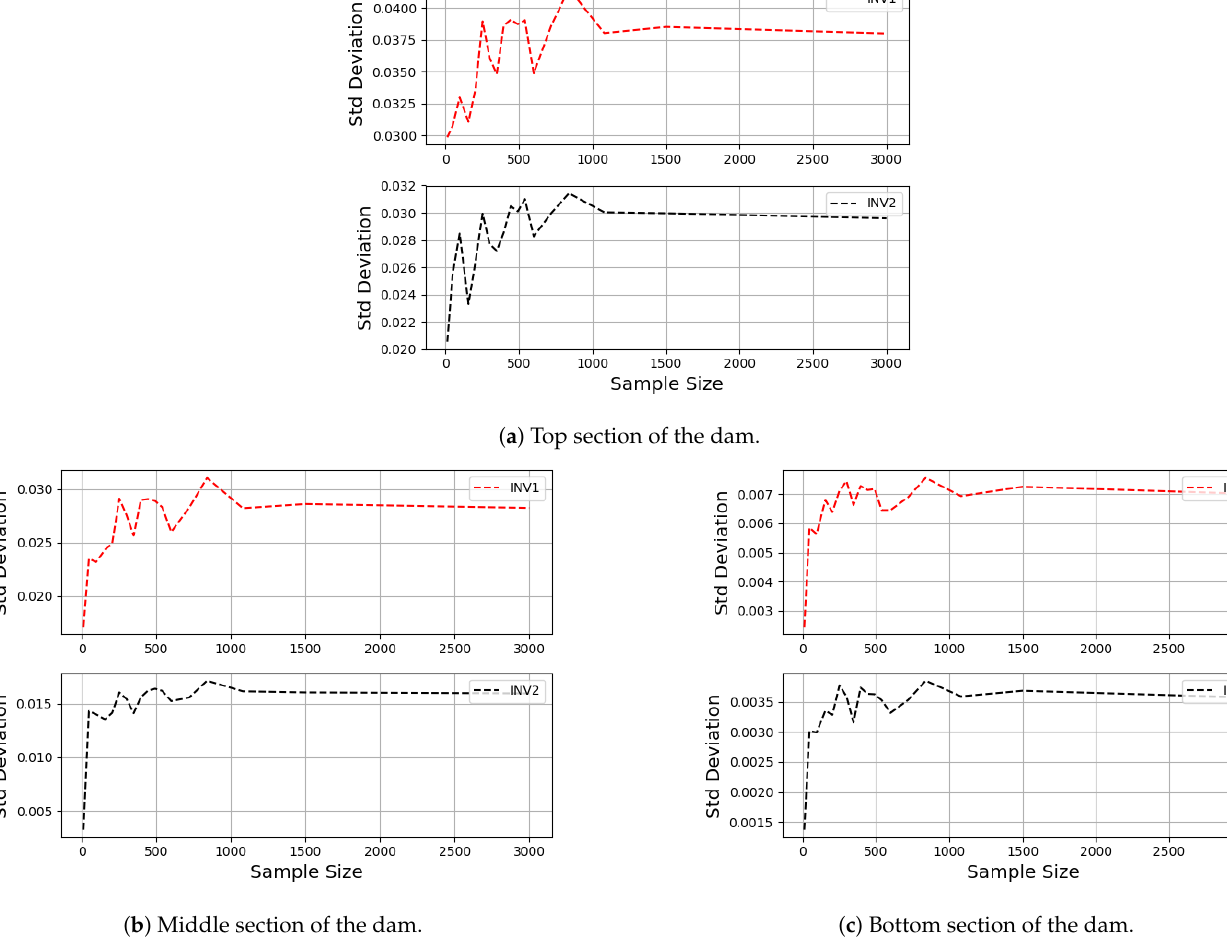
Figure 4. Variations of standard deviation (of the vertical displacement) with respect to the sample size for each inclinometer. The plots are built for the nodes close to the top, middle and bottom sections of the dam.